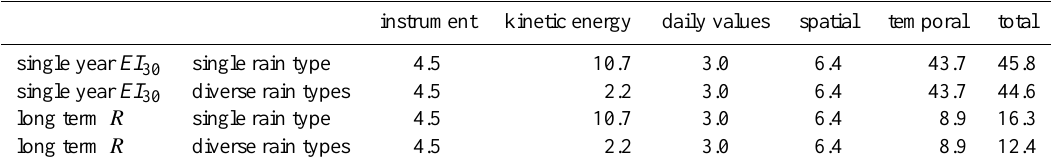
Table 4. Variation coefficients (percent values) estimated for rainfall erosivity ( EI 30 ) and long-term erosivity R factor, taking into account the diverse sources of